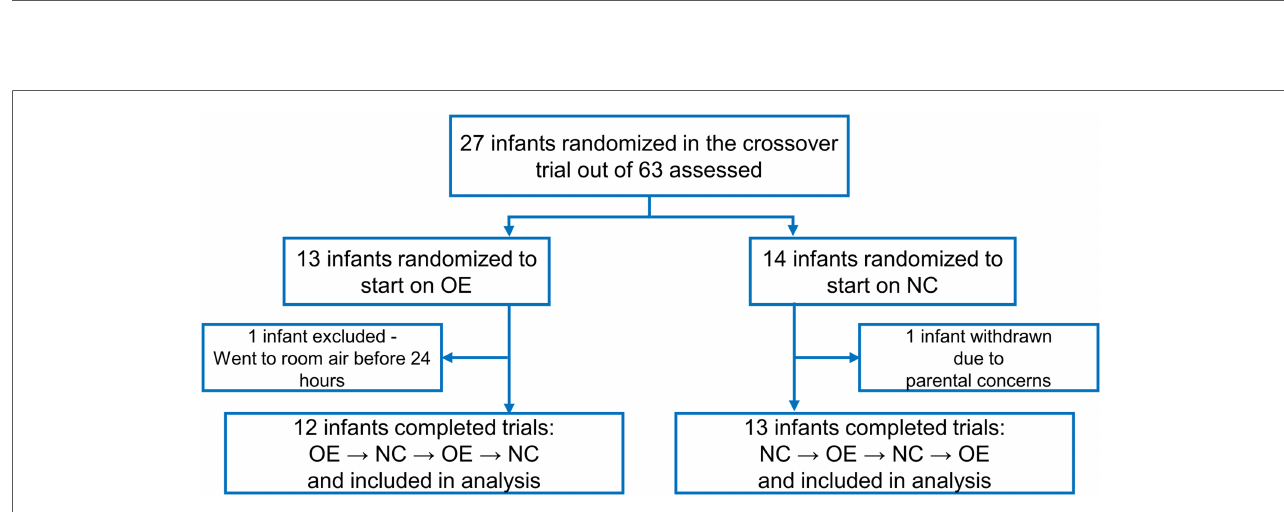
FIGURE 3 Flow diagram showing screening, randomization, and the number of infants included in the fi nal data analysis. OE is oxygen environment; NC is nasal